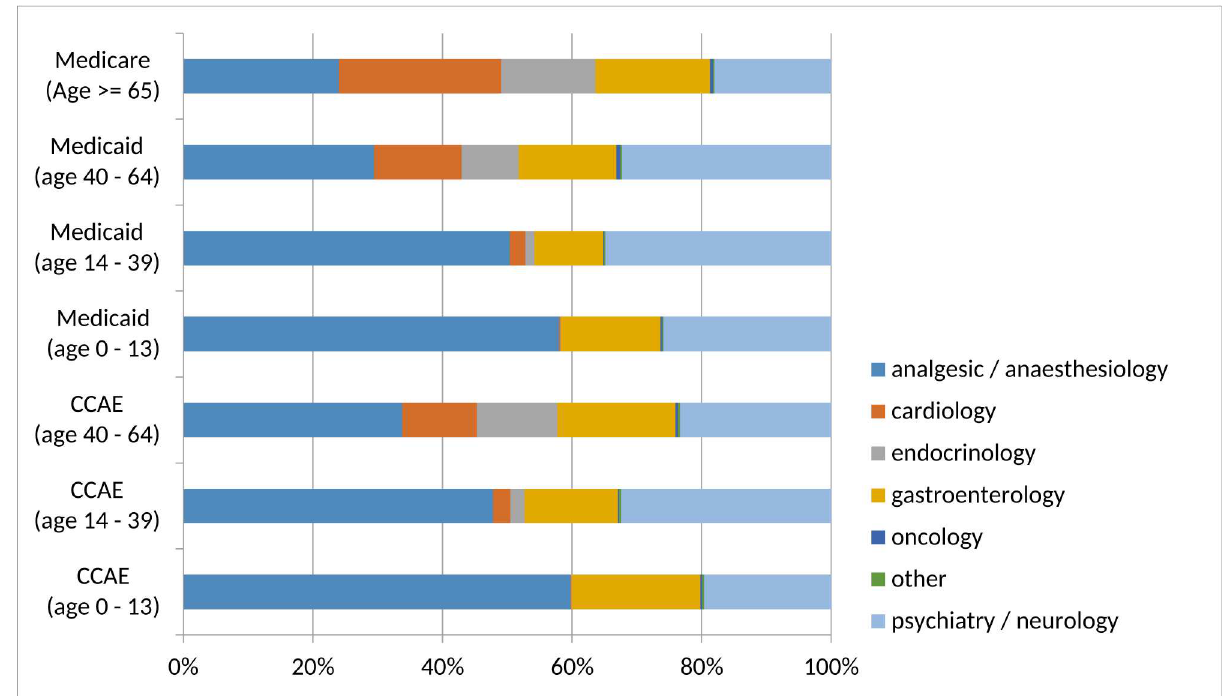
Fig 1. Distribution of incident use within four-year time window among therapeutic